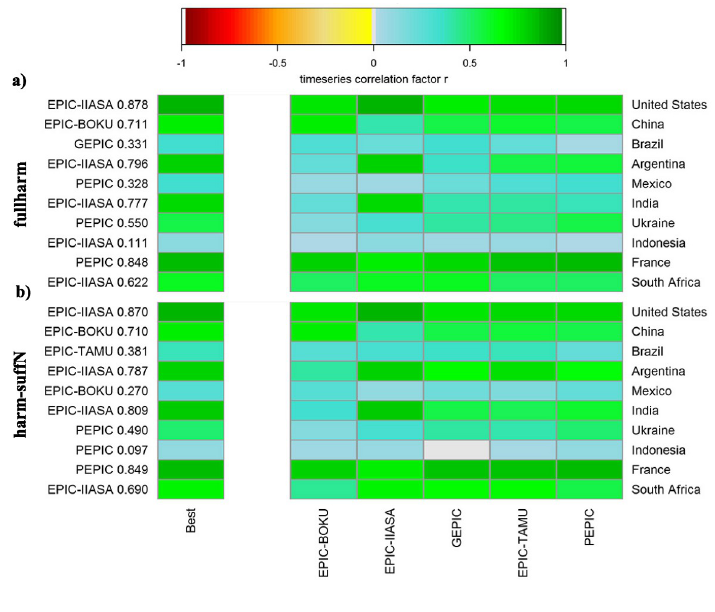
Fig 8. Time-series correlation coefficients against reported detrended yields for EPIC-based GGCMs in the top ten maize producing countries. (a) the fullharm and (b) the harm-suffN simulations. The best performing GGCM including r value is displayed on the left y-axis. Correlation coefficients for each GGCM and country are provided in Table K in S1 File.